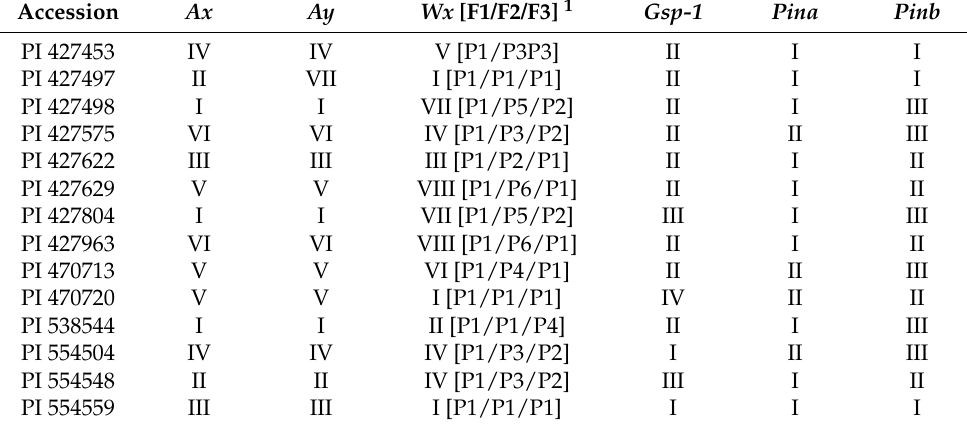
Table 1. Composition for each locus of the representative accessions